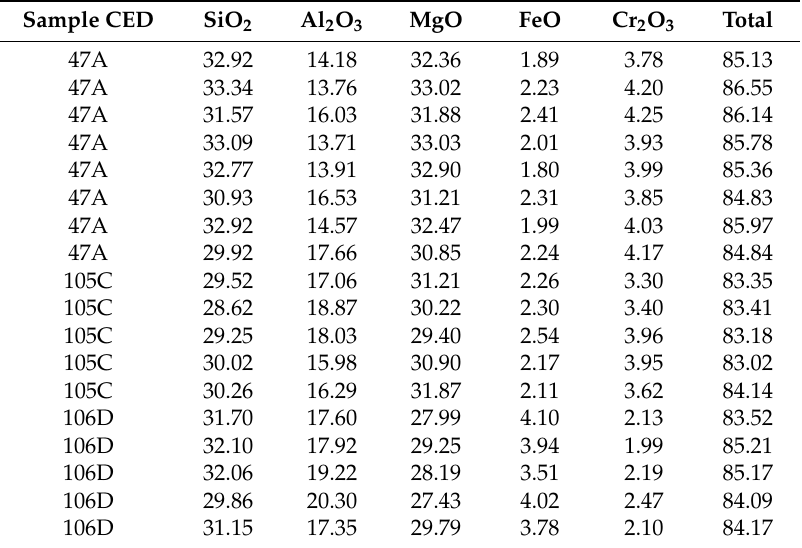
Table 1. Selection of representative electron microprobe analyses of chlorite from Cedrolina chromitite (wt